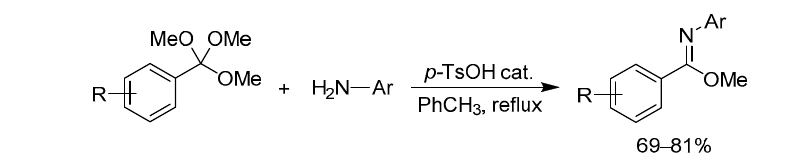
Molecules 2018 , 23 , x FOR PEER REVIEW 9 of 63 Scheme 9. Rh-catalyzed annulative coupling of methyl N -substituted benzymidates and aldehydes for the synthesis of 3-substituted phthalides.